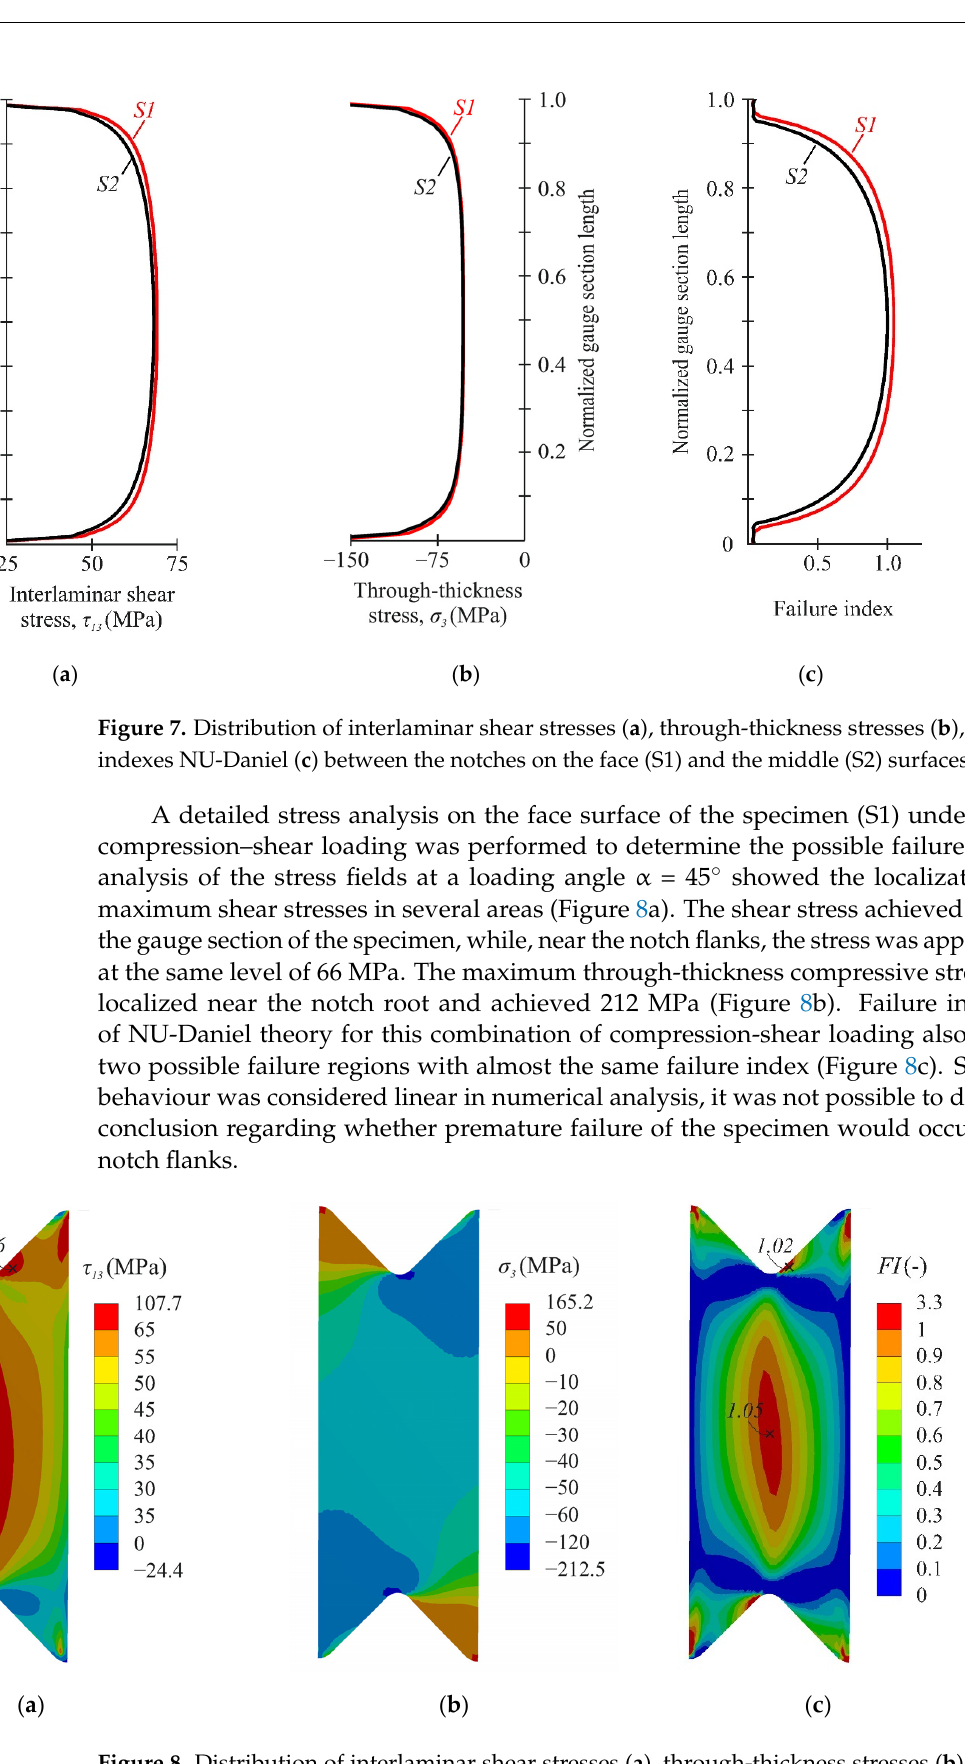
Figure 8. Distribution of interlaminar shear stresses ( a ), through-thickness stresses ( b ) and failure indexes NU-Daniel ( c ) on the face surface of the specimen at the loading angle α = 45°. A significant difference in the stress distribution was observed at small loading angles ( α < 20°). The maximum shear stresses at the loading angle α = 15° were localized near the notch flanks and achieved 83 MPa (Figure 9a). In this case, the shear stress in the gauge section for the corresponding combination of compression–shear loading was about 52 MPa. The maximum through-thickness compressive stresses were still localized at the notch root and achieved 542 MPa (Figure 9b). Failure index maps of the NU-Daniel theory for this combination of compression–shear loading testified the localization of failure near the notch flanks (Figure 9c). Figure 10 shows the distribution of stresses and failure indexes along the gauge section. Sufficient uniform stress distribution was ensured in the central part of the gauge section. The combination of interlaminar shear and through-thickness compressive stresses in the gauge section led to the different distribution of failure indexes (Figure 9c). Delamination was predicted in the central region of the gauge section at the loading angle of 45°, while a significant safety margin was provided at the loading angle of 15°. It was previously shown that the possible failure zone was localized outside the gauge section of the specimen at the loading angle of 15° (Figure 9c). In this case, the interlaminar strength under combined compression-shear loading will be underestimated due to the premature failure of the specimen. The combination of compression-shear loads corresponding to delamination in the gauge section was used as an initial approximation for the experiments.